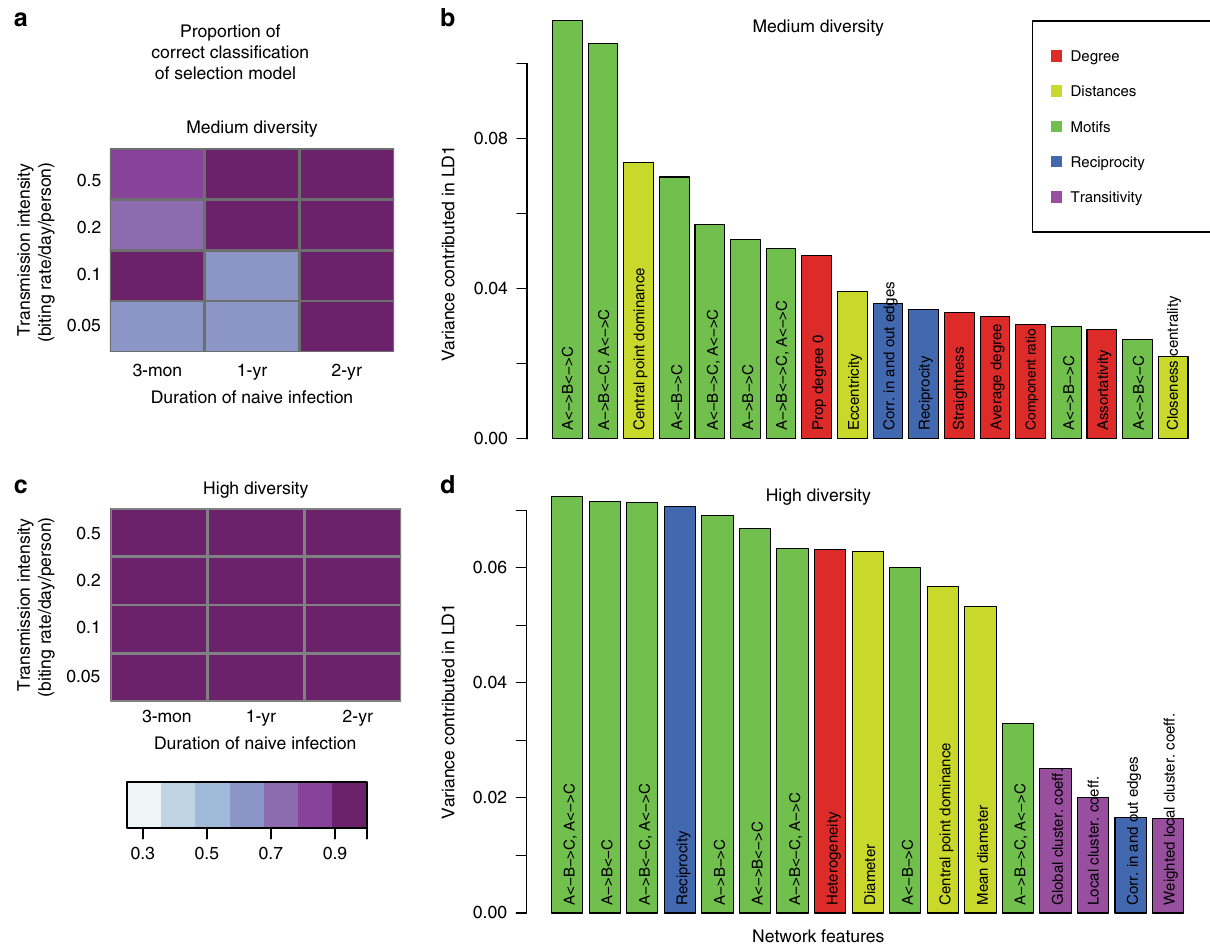
Fig. 3 Importance of network features for the classi fi cation and the power of correct classi fi cation of the selection model. Results are for different levels of duration of naïve infection, biting rate, and var gene pool size (medium diversity [1,200 – 2,400] in a , b and high diversity [12,000 – 24,000] in c , d ). a , c The shade of colored squares indicates the proportion of correct assignments of the immune selection scenario. Variance contribution of network features in the fi rst linear discriminant function (LD1) are displayed with color-codes corresponding to the feature groups ( b , d ; see Supplementary Table 1 for feature groups). Only top features that explain at least 90% of the variance are shown. In simulations with a gene pool of medium diversity a , the proportion of correct assignments of the selection model increases with increasing infection duration and biting rate. When the genetic pool is of high diversity, the selection model is almost always perfectly assigned c , while neutral and generalized immunity models are harder to differentiate, even under high transmission and long infection durations (see Supplementary Table 2). The proportions of different motifs are the most important features